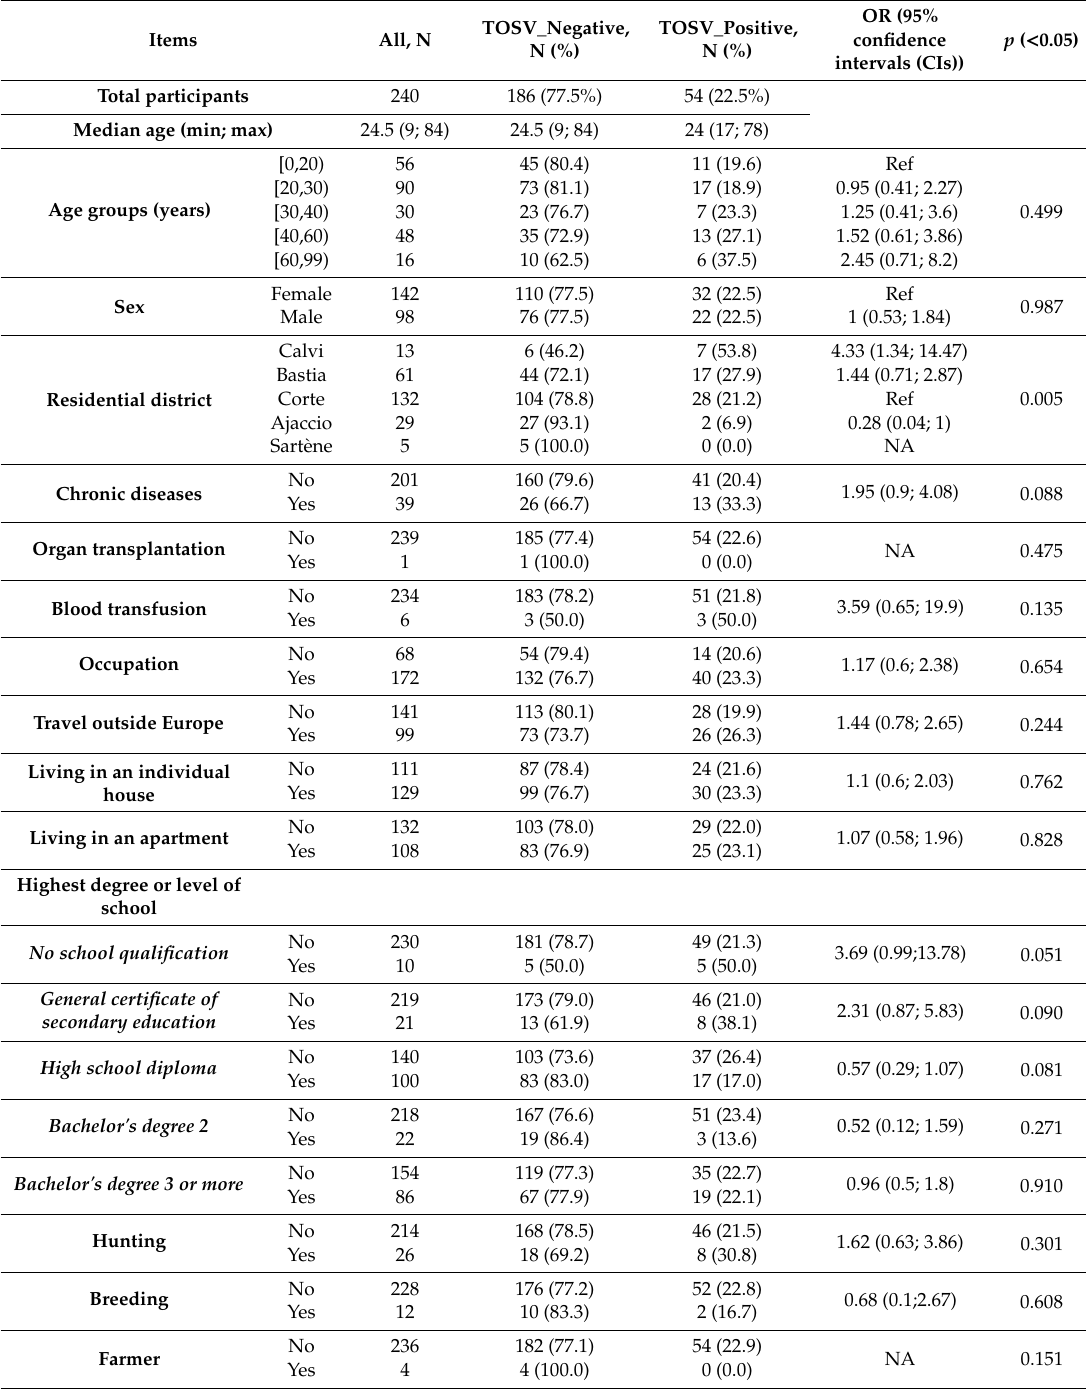
Table 1. Description of the population and univariate analysis of factors associated with Toscana virus (TOSV) seropositivity, odds ratio (OR), and p